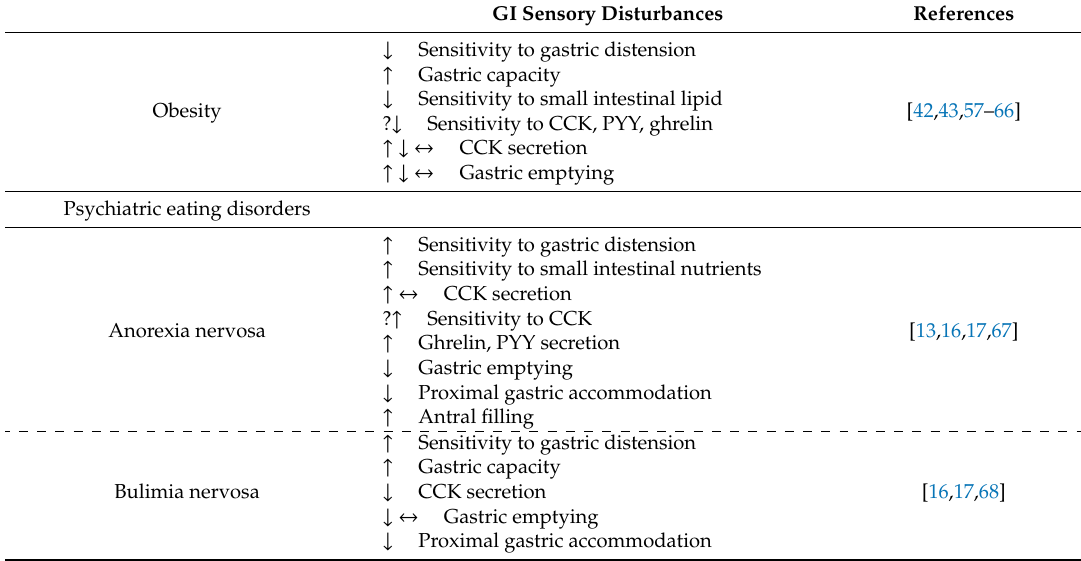
Table 1. Changes in upper GI luminal sensing that have been described in eating-related disorders. GI Sensory